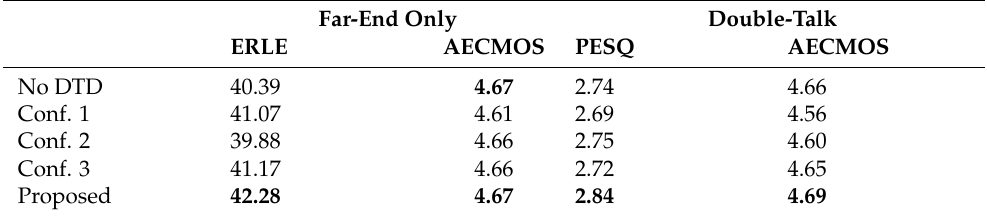
Table 2. Study of different configurations of the masking model with a DTD. Conf. stands for